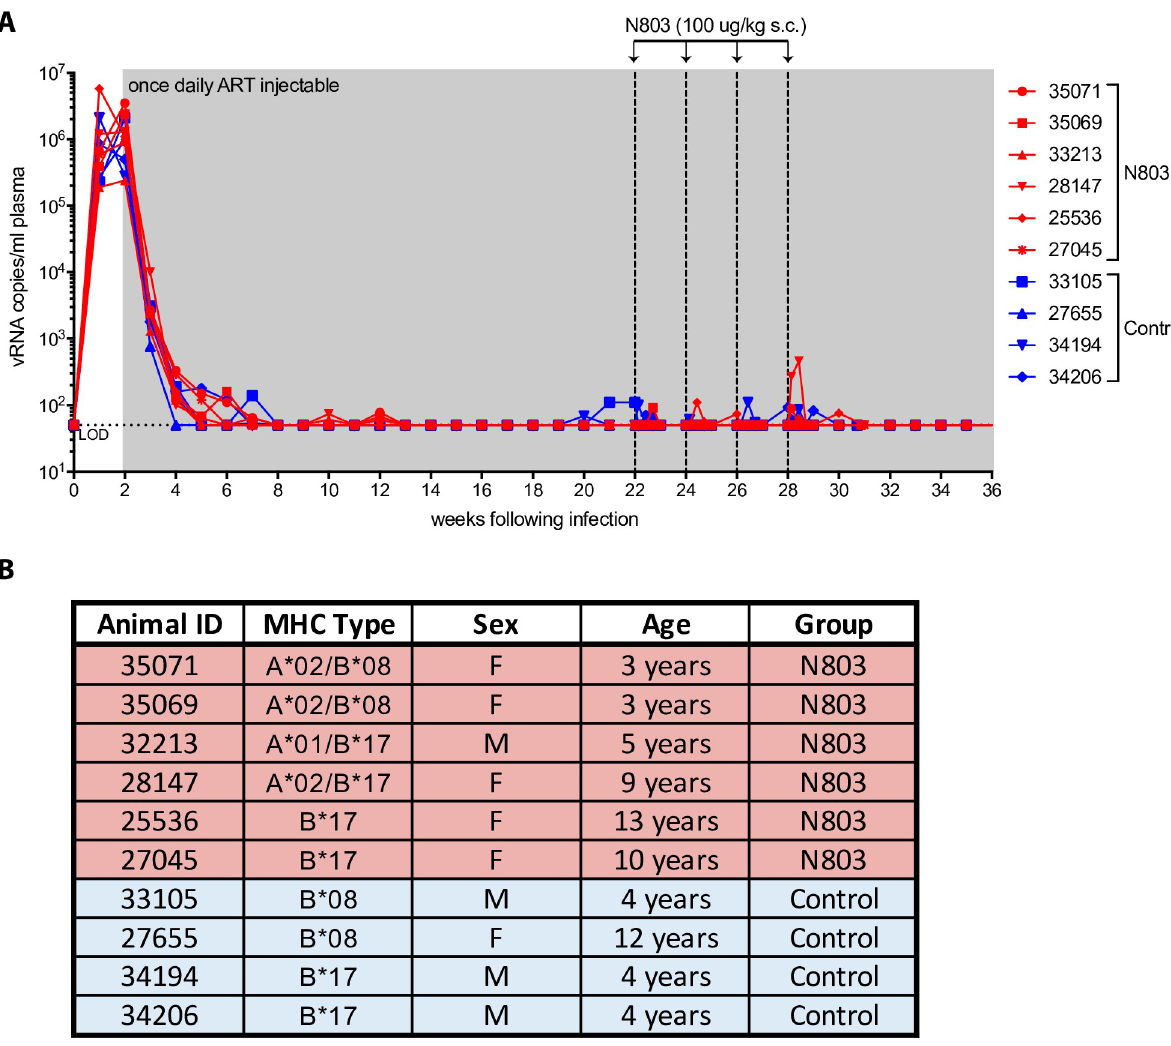
Fig 1. Plasma viral loads after infection with SHIVsf162p3 and before discontinuation of ART. We intravenously infected rhesus macaques (n = 10) with SHIVsf162p3 and initiated ART at week 2. The N-803 group (n = 6, red) received 4 subcutaneous infusions of N-803 (100 μ g/kg) every other week, indicated by vertical dashed lines between weeks 22–28. The control group (n = 4, blue) was left untreated. Horizontal dotted line indicates limit of detection (LOD) at 50 RNA copies/mL. (A) Plasma viral loads shown prior to ART discontinuation and during N-803 treatment. (B) Table of research animal characteristics including animal identification number, MHC type, sex, age, and the group to which the animal was assigned.